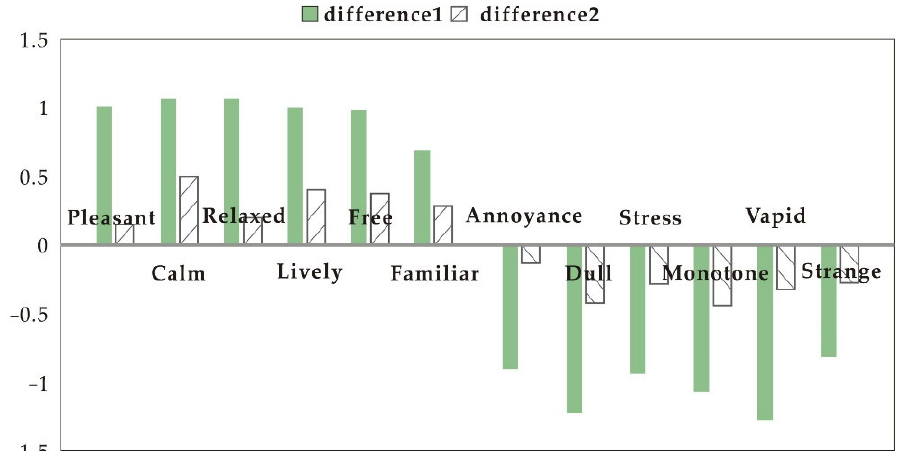
Figure 5. Differences in emotion perception (white noise). Difference 1: average difference in emotion perception between sample and no speakers; difference 2: average difference in emotion perception between sample and electronic speaker.